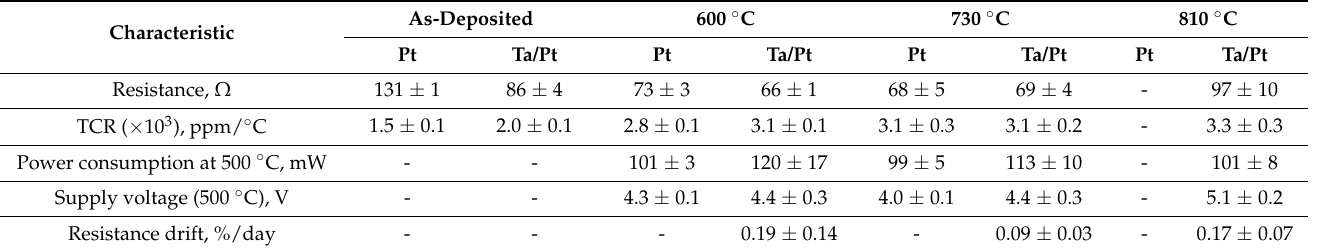
Table 1. Parameters of Pt and Ta/Pt microheaters annealed at different temperatures for 12 h. The data was averaged over at least three microheaters in each case. The duration of the resistance drift measurement is 1